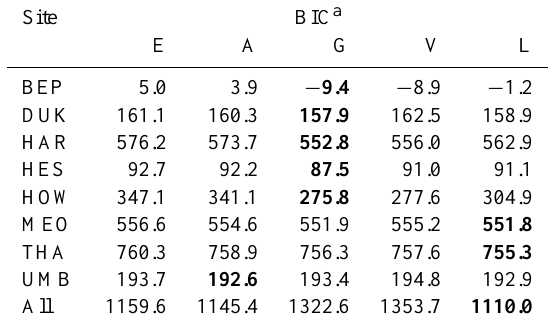
Table 4. Ranking of nonlinear model fits